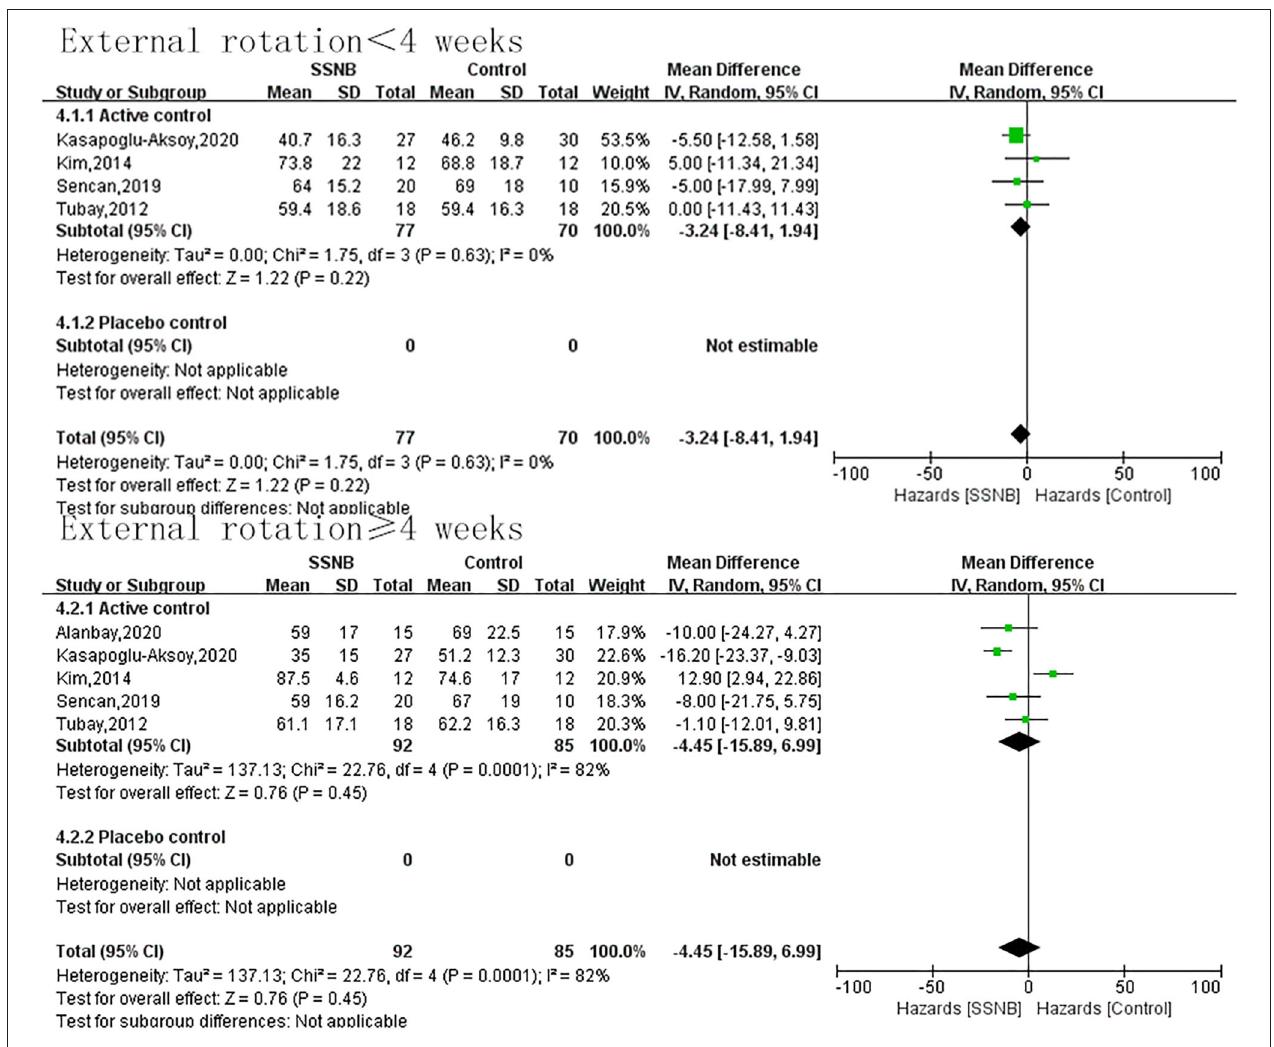
FIGURE 5 | Forest plot of external rotation ROM between SSNB and other treatment.